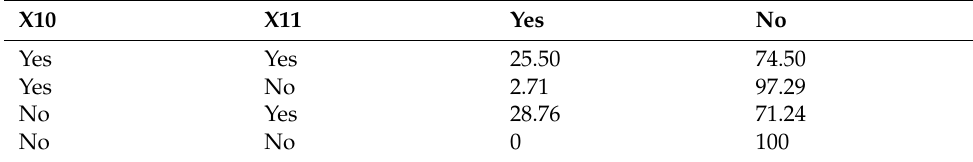
Table A7. Conditional probability of node M3.